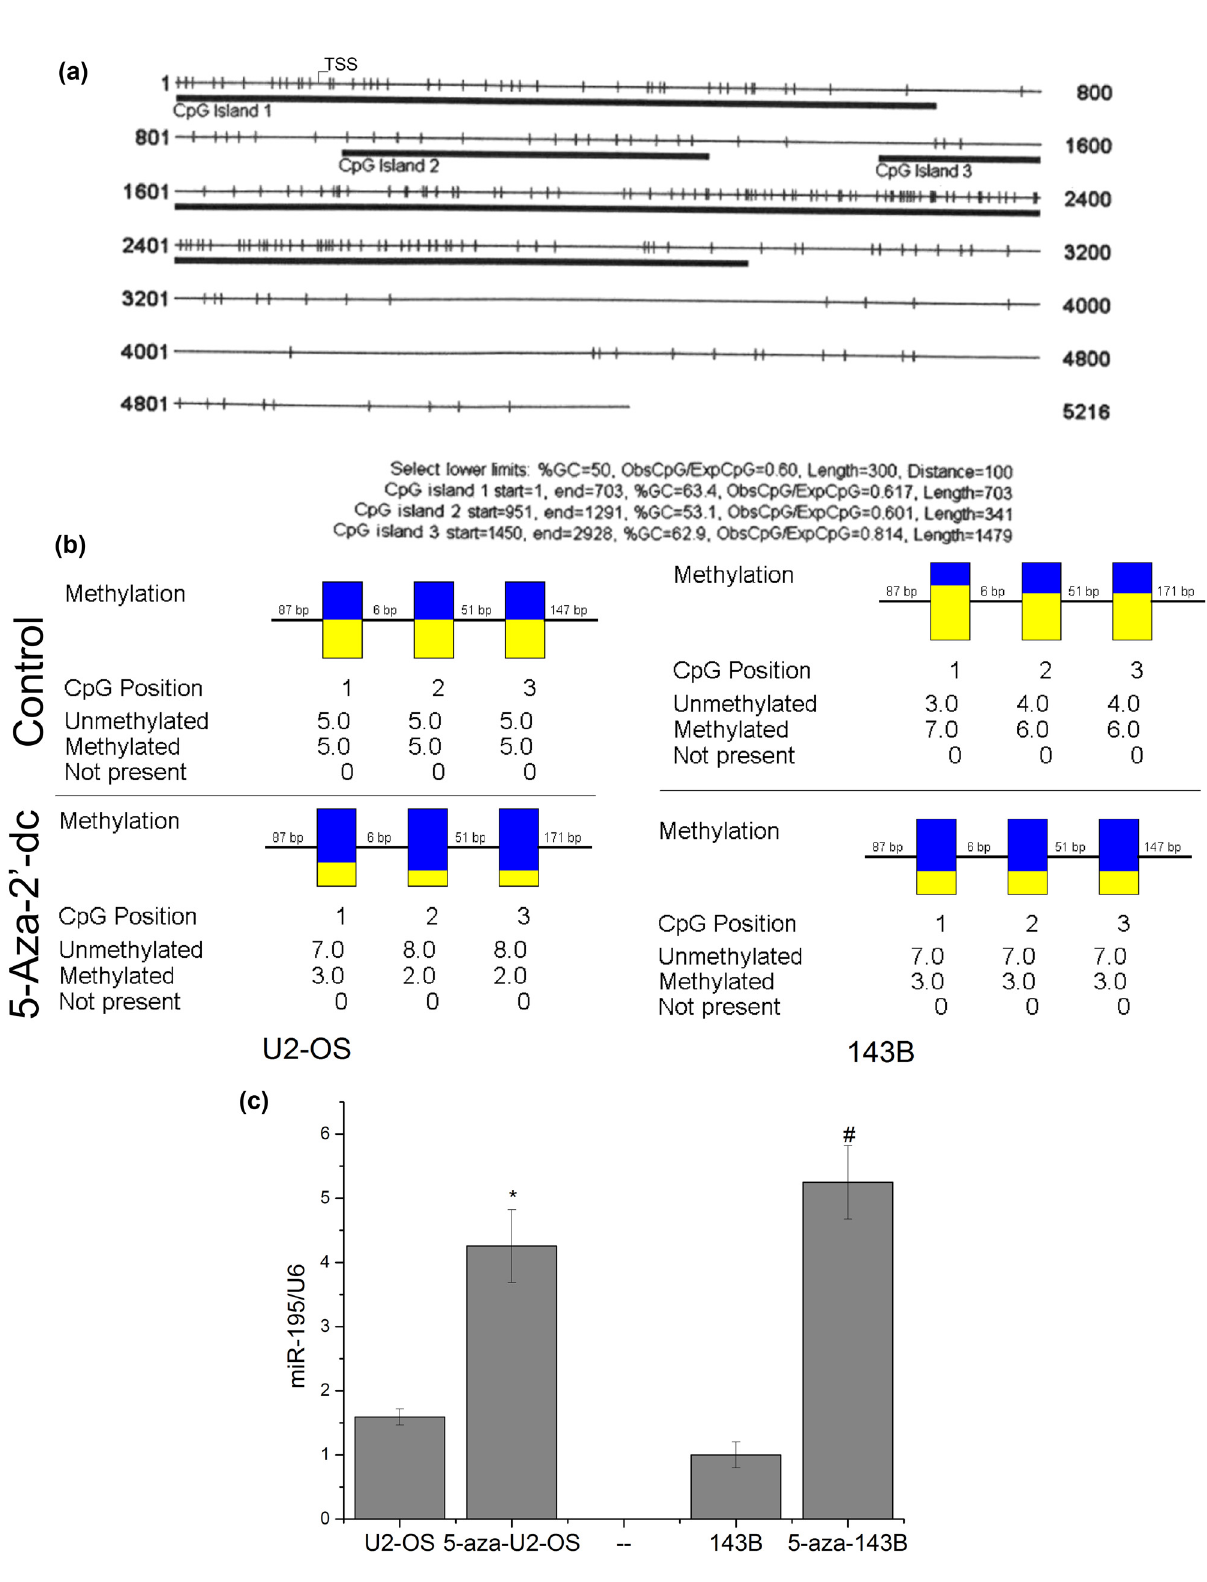
Figure 4: The methylation of miR - 195 was one of the reasons why miR - 195 decreased. ( a ) The prediction results showed that the promoter region of miR - 195 is full of CPG islands. ( b ) Bisul fi te sequencing PCR ( BSP ) assay showed that the methylation levels of the miR - 195 promoter region were signi fi cantly downregulated on cells treated with 5 - aza - 2 ′ - dc ( n = 6 ) . ( c ) The expression level of miR - 195 was signi fi cantly upregulated in U2 - OS and 143B cells treated with the demethylation reagent in vitro ( n = 6 ) . The error bar represents the standard variation of the miR - 195 levels in the U2 - OS or 143B cells treated with 5 -